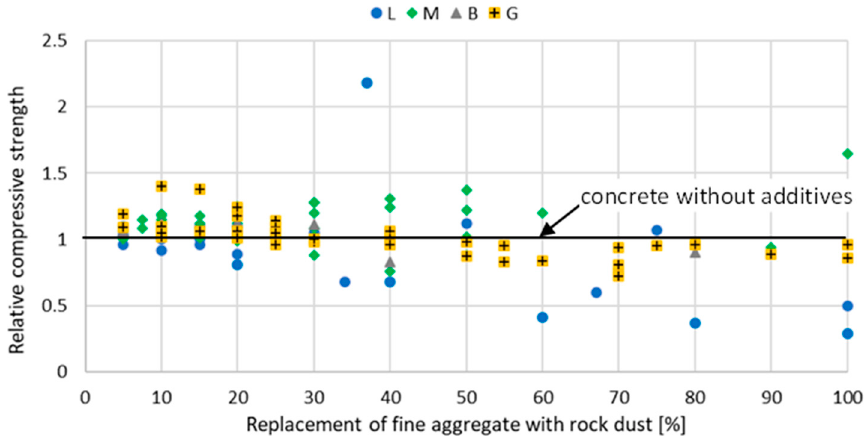
Figure 4. The effect of replacing fine aggregate with rock dust on the compressive strength of mortar after 90 days of curing: limestone dust (L) [46,55,95], marble dust (M) [63], basalt dust (B) [46,55,57,96], granite dust (G) [95], quartz dust (Q) [95].